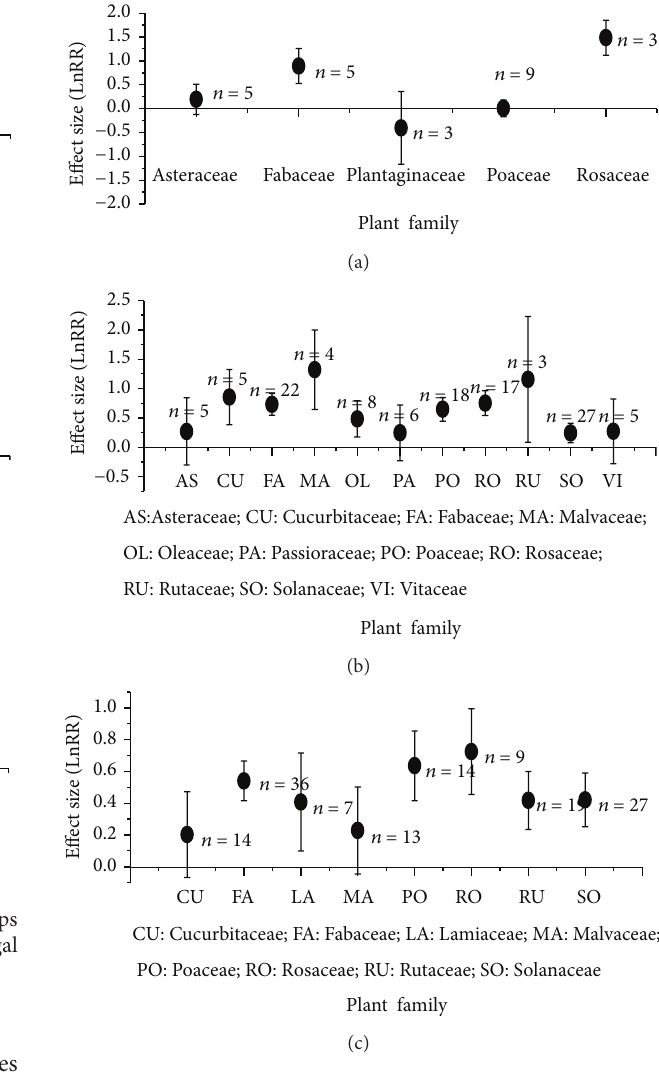
Figure 3: Effect size ( mean ±95 % CI ) of plant family to AMF under attacks of herbivores (a), nematodes (b), and fungal pathogens (c).